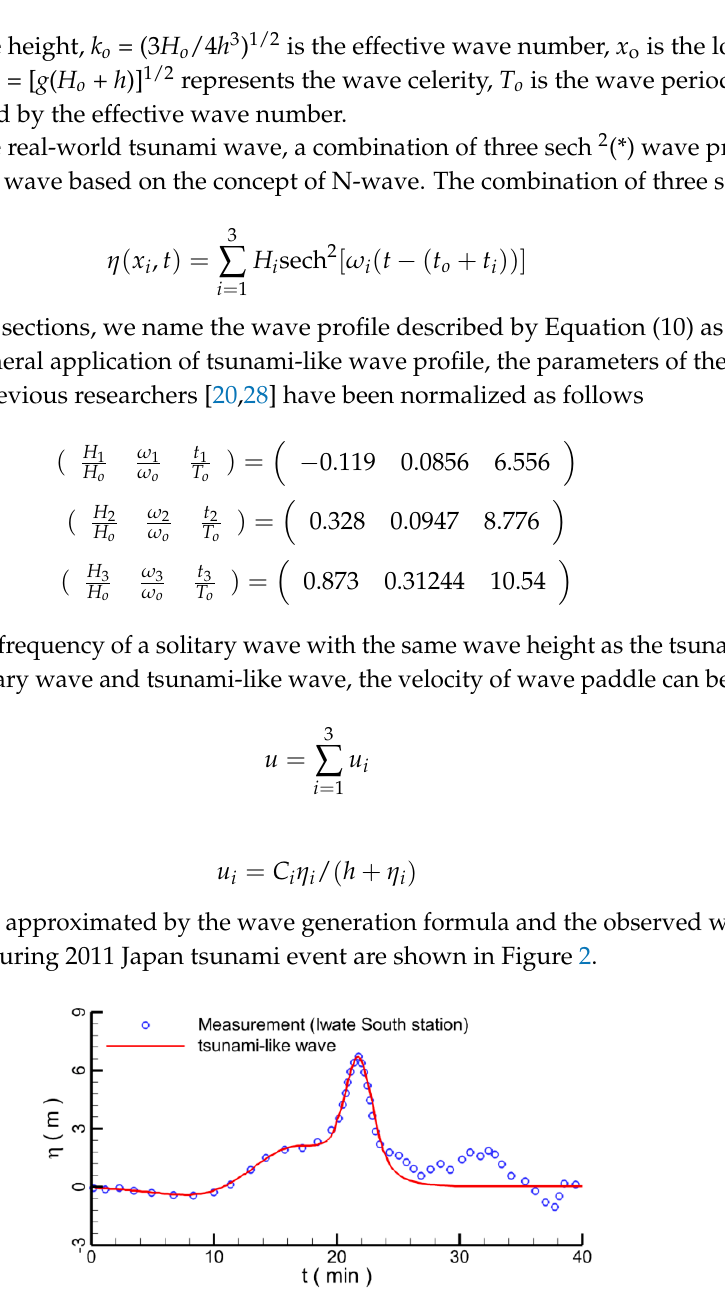
Table 1. Parameters of selected experimental runs. Run